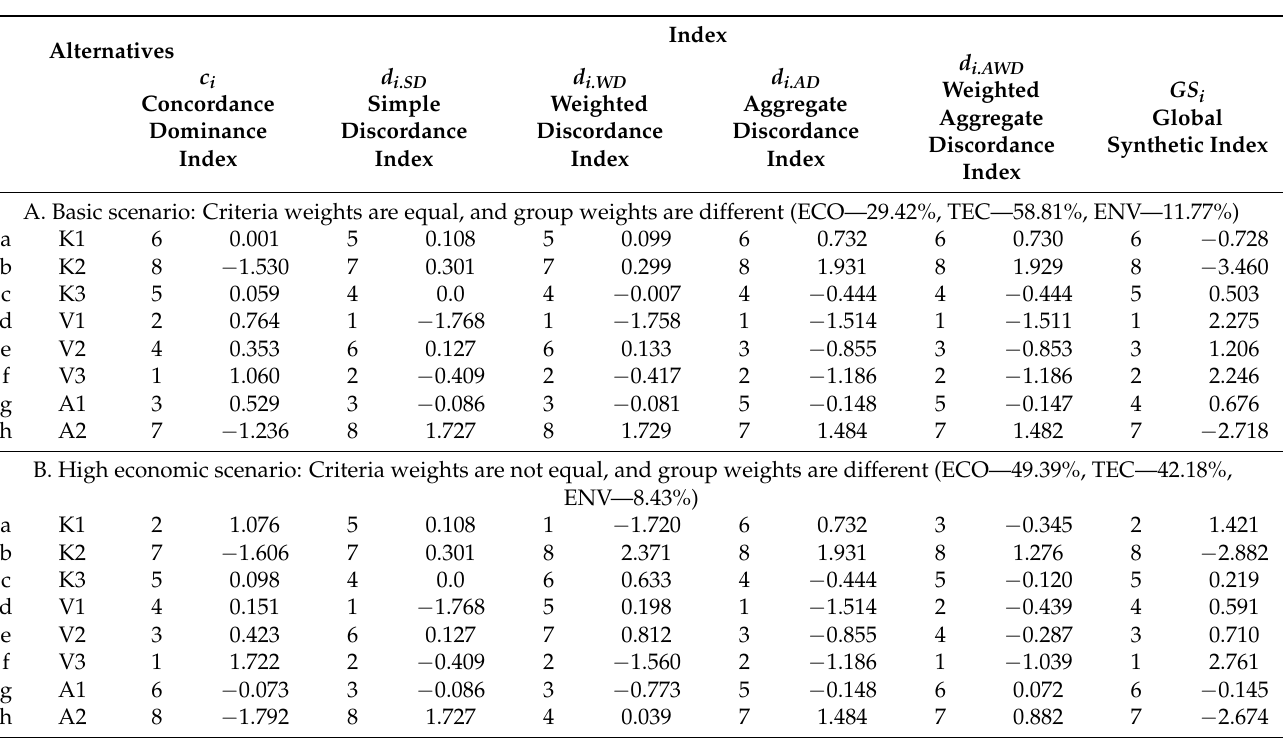
Table 8. Summary of rankings with the final ranking global synthetic index ( GS i ): 1 = best position; 8 = worst